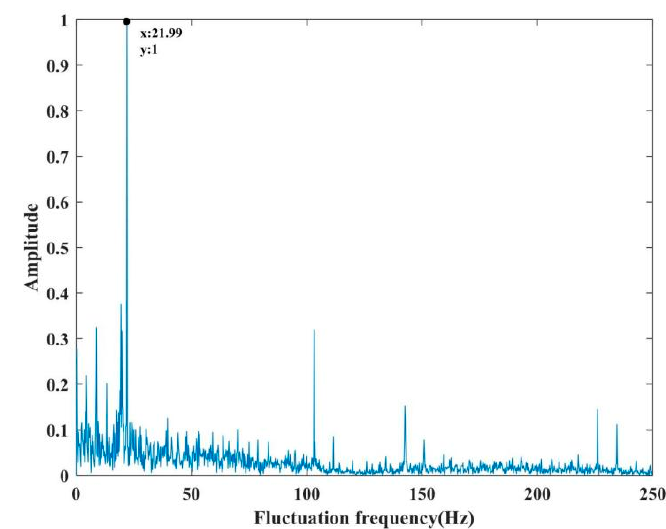
Figure 11. Fluctuation frequency of magnetorheological polishing ribbon.